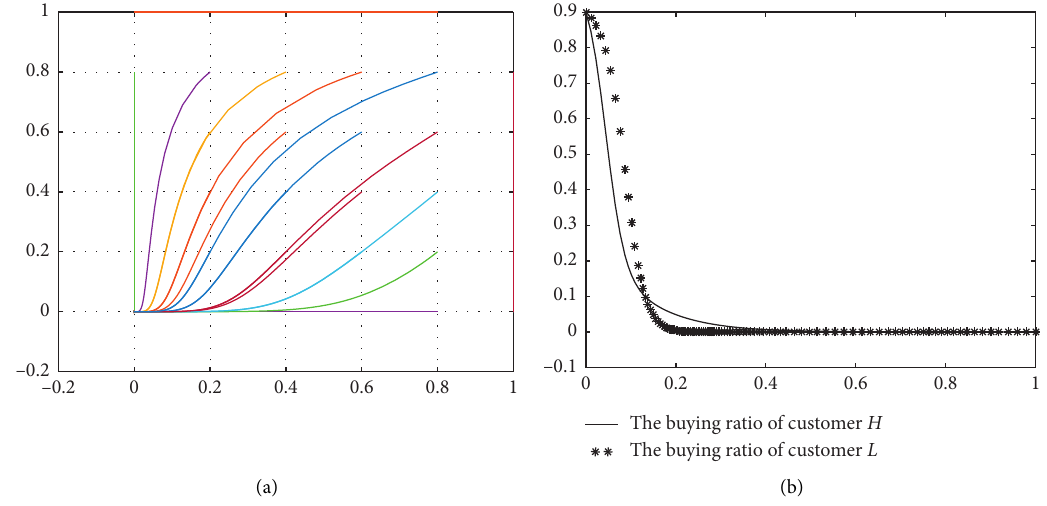
Figure 3: (a) ESS at P > (( 2 + k ) S − r ) /2. (b) System evolution at P > (( 2 + k ) S − r ) /2.